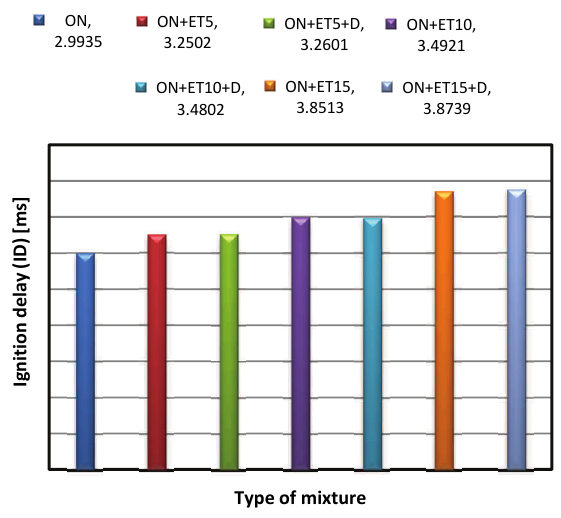
Fig. 5. Auto-ignition delay (ID) values for the blends tested